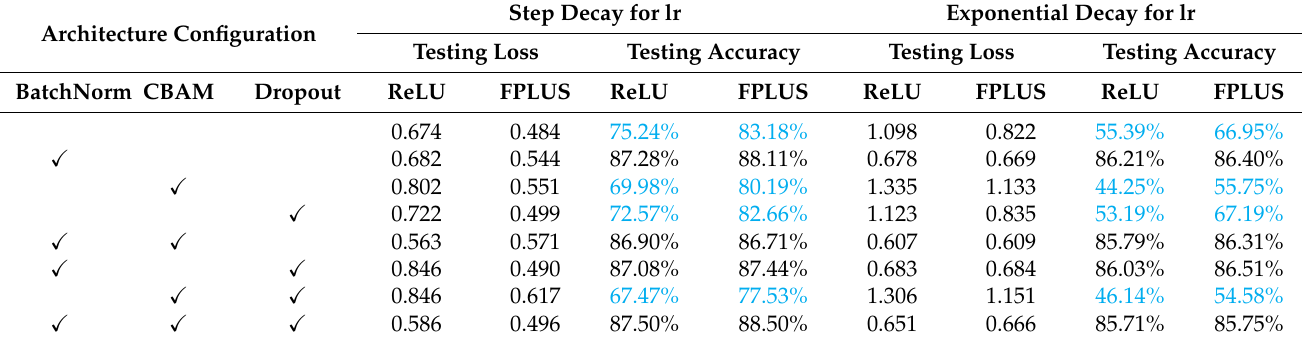
Table 2. Comparison of loss and accuracy for training Intel image classification dataset on ResNet-50 with multiple network configurations, grouped by two ways of learning rate decay.